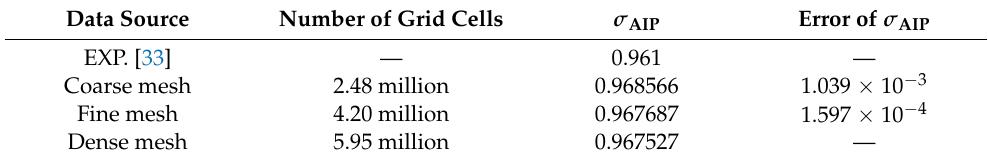
Table 3. Inlet performance calculated with different resolved meshes at M = 0.7 and p AIP / p 0 =